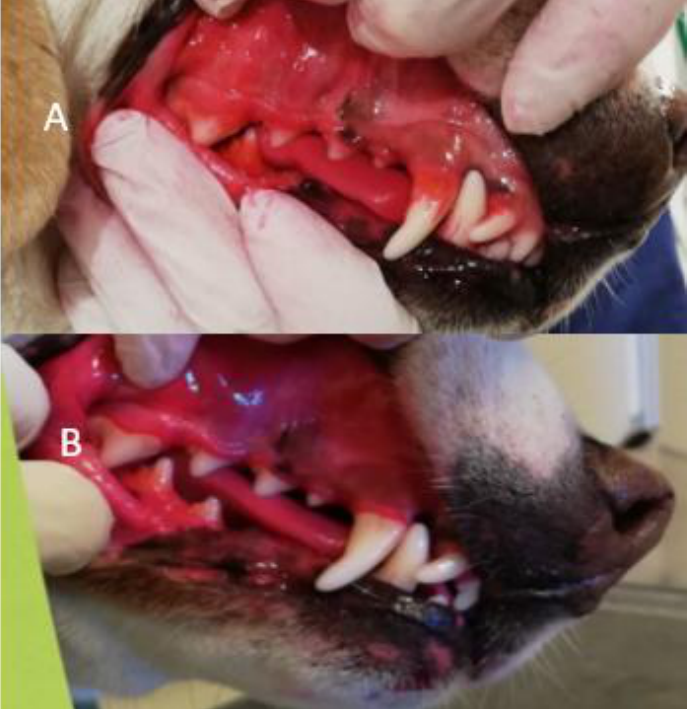
Figure 4. Dog ‘ Textile 1 ′ ( A ): first staining; and ( B ): after 35 days with daily dental cleaning with microfiber finger cloth. The bacterial plaque is stained red. (Photo: Fanny Eriksson).